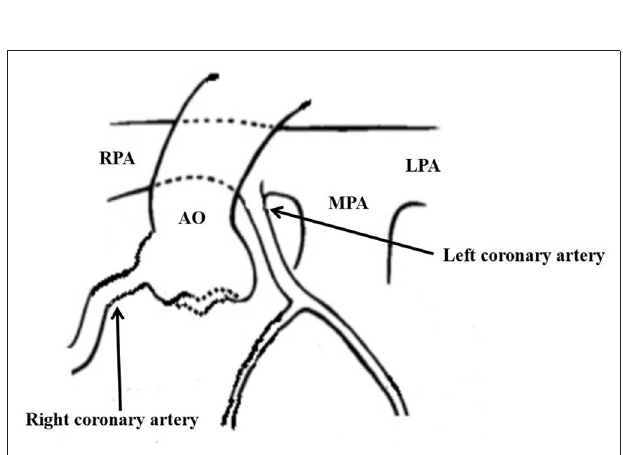
FIGURE 3 | The abnormality of left coronary artery originated from the posterolateral wall at the beginning of right pulmonary artery.